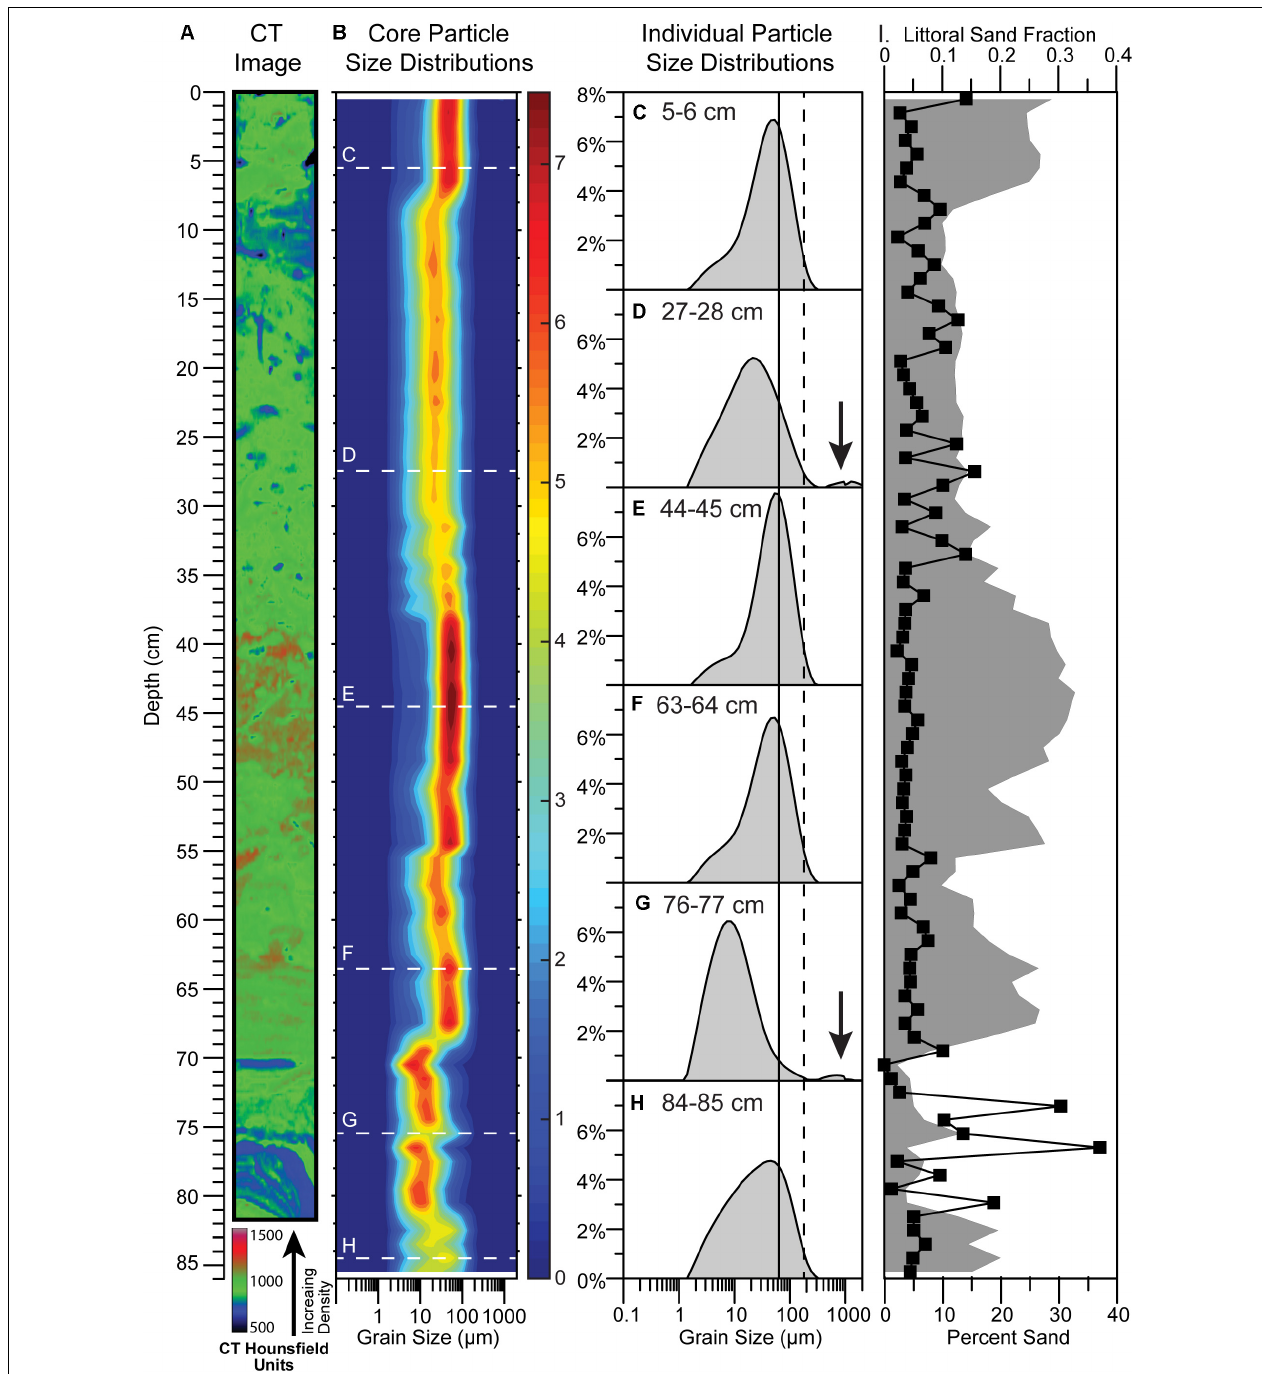
FIGURE 7 | Results from PS1410-08GC (see Figure 1 for location). (A) CT image of the core where cooler colors (blues and greens) are relatively lower density deposits, and warmer colors (reds) are higher density. (B) Down core total grain size distribution for all samples. In this plot the y-axis is depth down the core, x-axis is particle size, and the colors represent the volume present of the sample that fall within those size classifications, where warmer colors are higher percentages and cooler colors are lower percentages. The warmest color region across any depth horizon represents the mode for the sample. Representative individual sample particle size distributions (PSD) are shown in (C–H) , where the depths of these PSD are highlighted in (B) as white dashed lines. The solid black vertical line in (C–H) notes the silt/sand boundary at 63 µ m and the dashed black vertical line notes the Monterey Bay littoral cutoff diameter at 180 µ m (see text for explanation). Black arrows in the plot point to samples with increases in material coarser than the littoral cutoff diameter. The raw measurement size bins for the instrument were used to create the distributions in (B–H) . (I) Down core results from the grain size analysis with total percent sand (gray area) and the littoral sand fraction (black squares – see text for explanation). For geochronological results from this core, see Figure 2 or Table 1 .